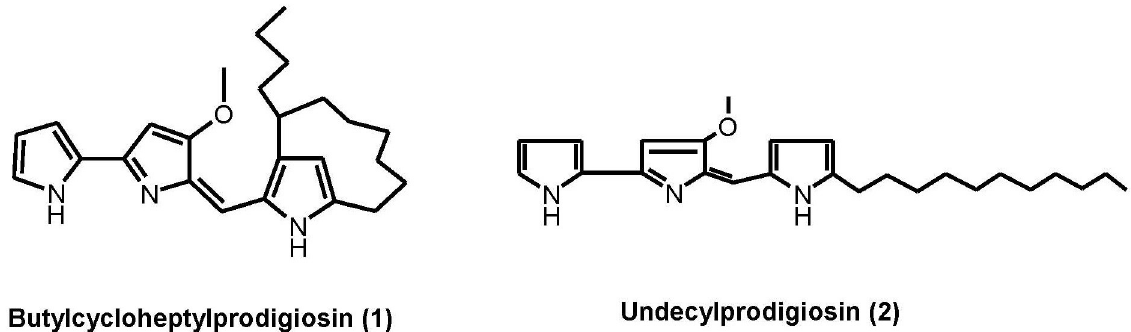
Fig 2. Structure of prodigiosins isolated from the actinomycete RA2. ( 1 ) Butylcycloheptylprodigiosin and ( 2 ) undecylprodigiosin.